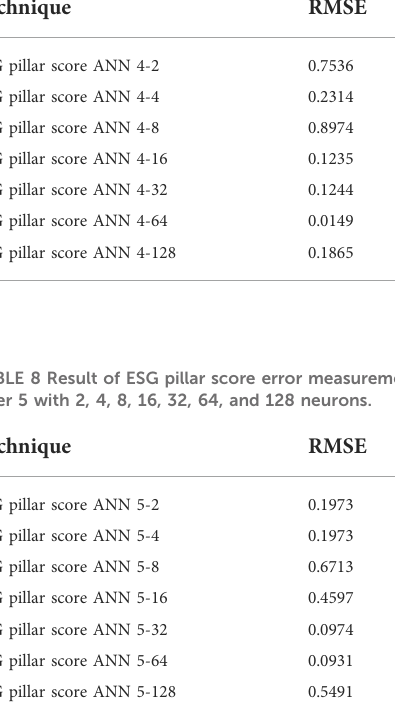
TABLE 7 Result of ESG pillar score error measurement using hidden layer 4 with 2, 4, 8, 16, 32, 64, and 128 neurons. Technique